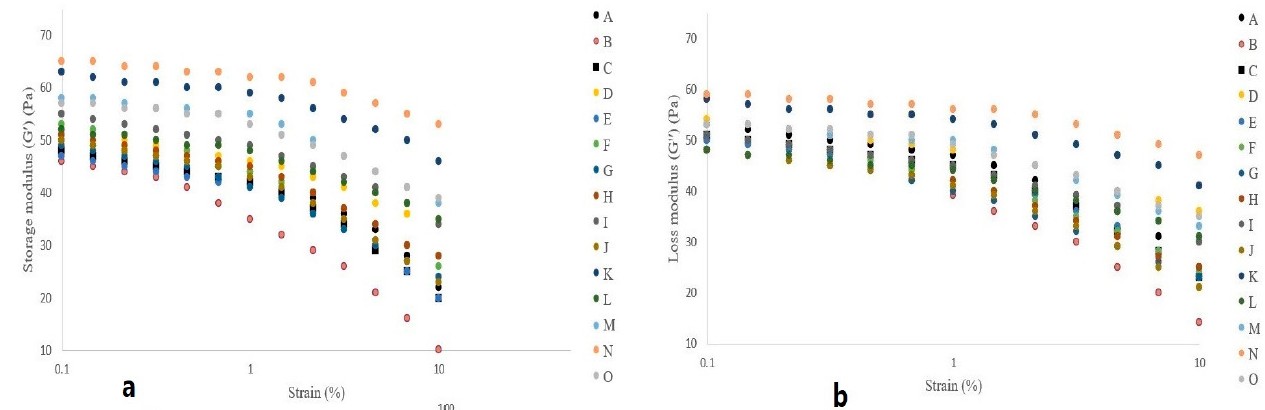
Figure 2. ( a ) Strain sweep profile of the samples with two biopolymers (FG and XG) for G ′ changes (Angular frequency: 1 rad/s) ( b ) Strain sweep profile of the samples with two biopolymers (FG and XG) for G ″ changes (Angular frequency: 1 rad/s). Table 4. Strain sweep parameters of the emulsions containing two hydrocolloids (fenugreek galac-